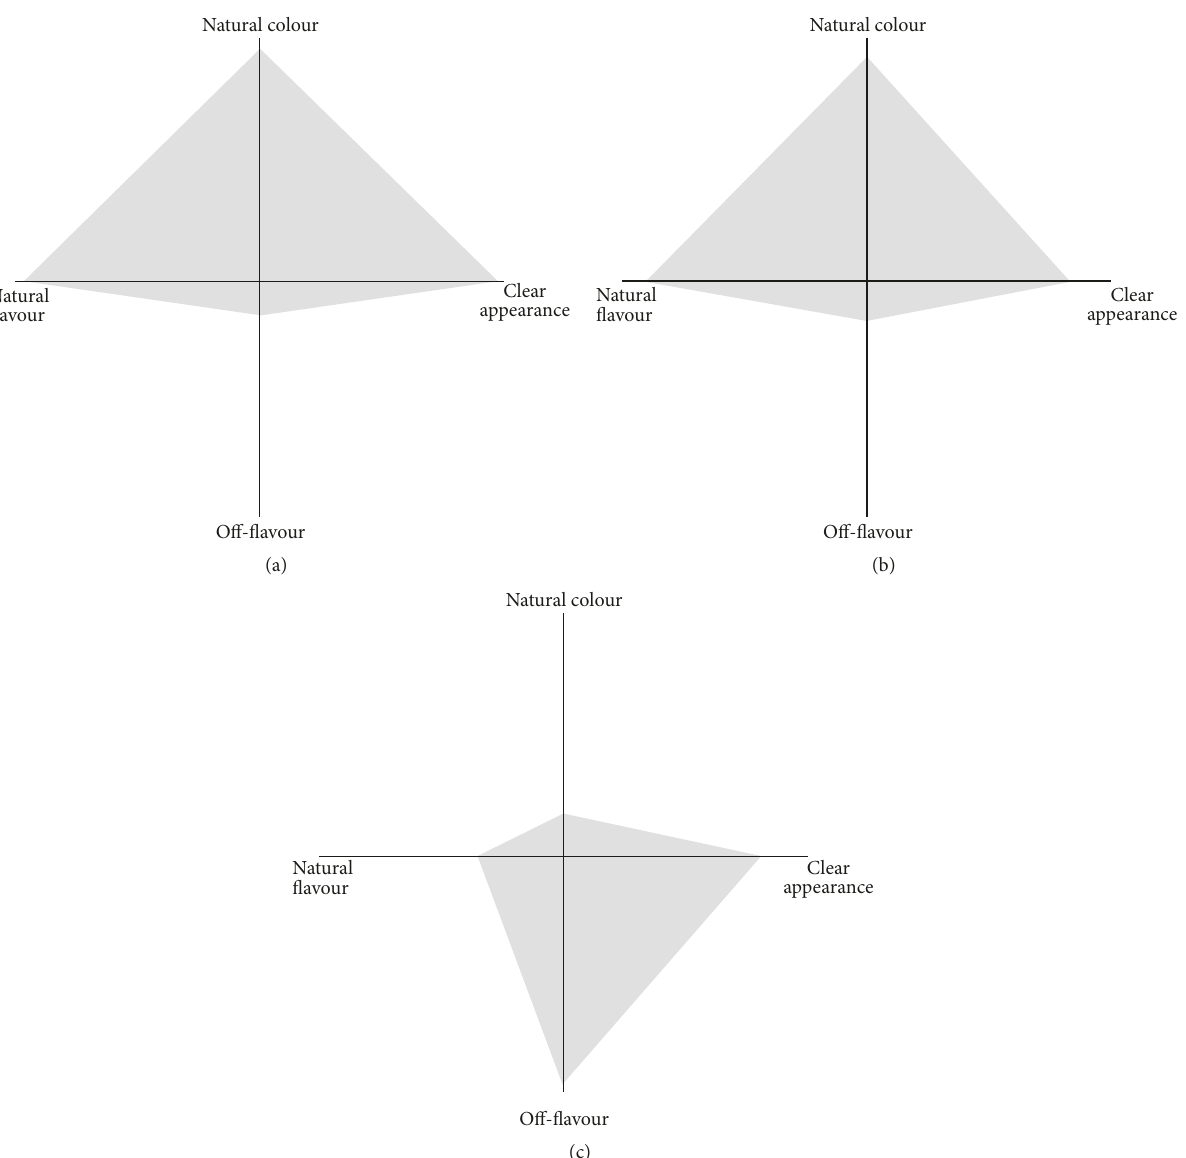
Figure 1: Sensory map of tea and fortified tea prepared using different Fe:EDTA ratios. (a) Natural tea, (b) 1:2 fortified tea, and (c) 1:1 fortified